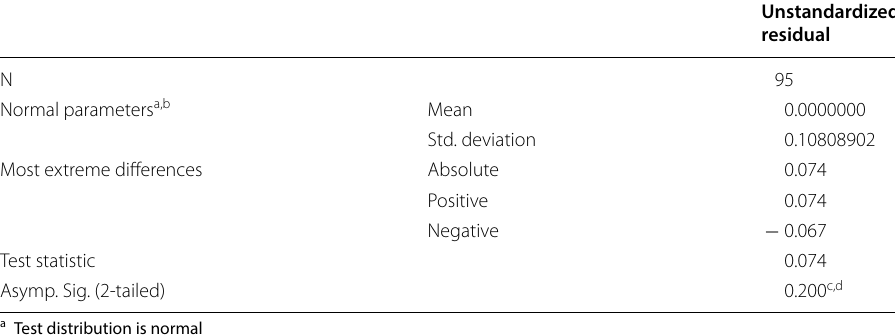
a Test distribution is normal